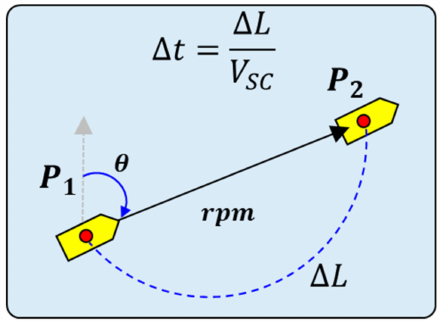
Figure 7. Calculation of ∆ t using the corrected speed V SC.